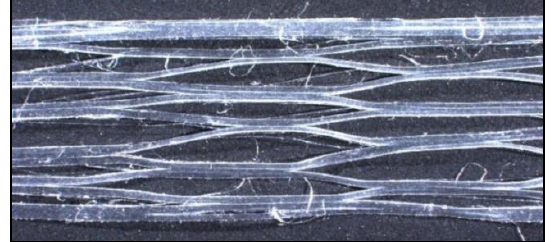
Figure 2. Image of SFPF (single fibrillated-tapes polypropylene fibers) fiber stretched transversely as a result of mixing the components of soil-cement, 10× magnification.